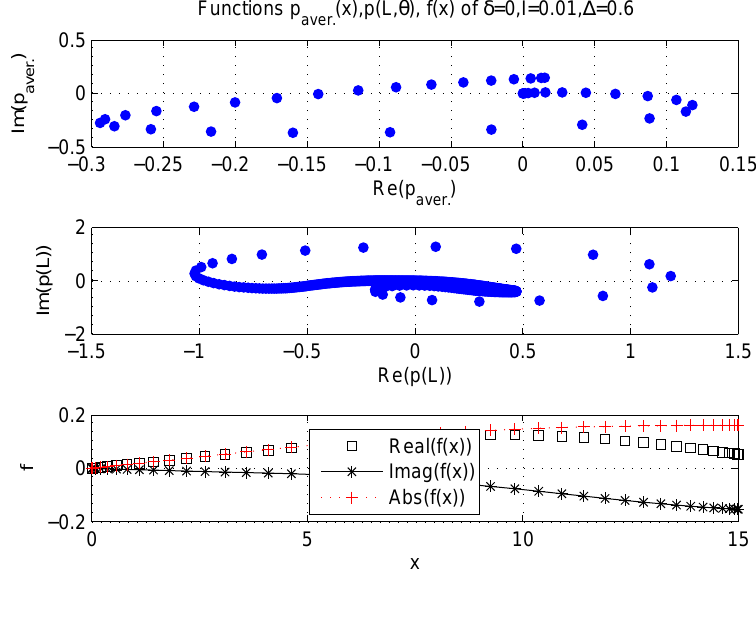
Fig. 1 shows distributions of the averaged value of p and the values p ( L ) in the complex plane for M = 360 , and the values of the function f ( x ) (real, imaginary parts and modulus with respect to x ).